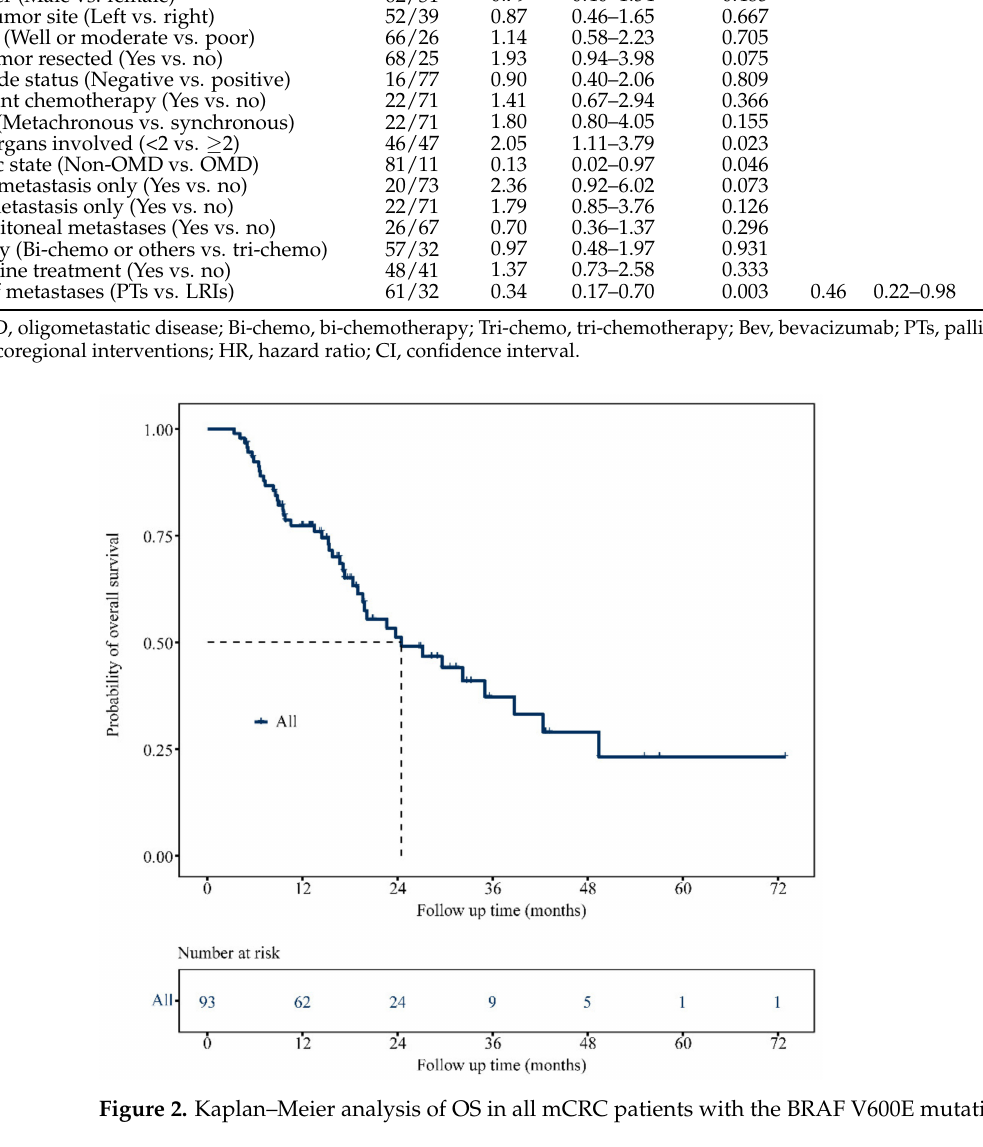
Table 2. Univariate and multivariate Cox proportional hazards analysis of overall survival for mCRC patients with the BRAF V600E mutation. Univariate Cox Analysis Multivariate Cox Analysis Variables N HR 95% CI p Value 95% CI p Value Age at metastases (<65 vs. ≥ 65)